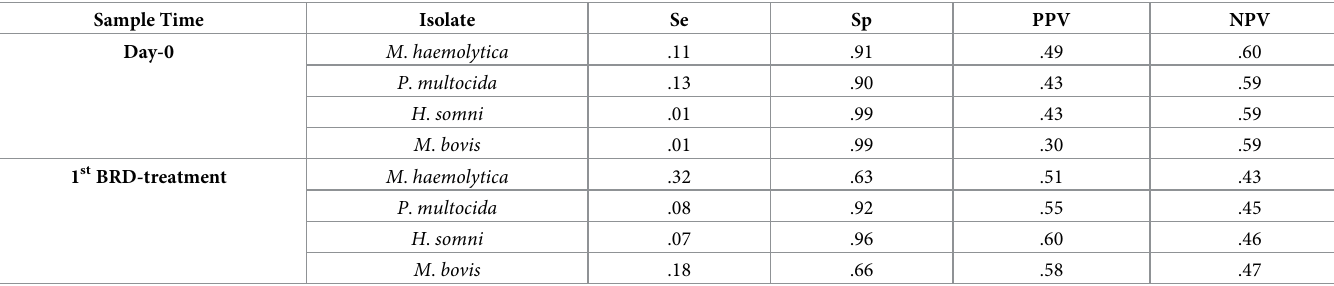
treatment is summarized in Table 6. Prevalence of positive PCR results for these four common respiratory viruses was over 50% for BRSV, over one third for bPIV-3, and one fourth for BVDV in this study population of high-risk feeder cattle. Table 7 shows that high-risk feeder heifers with positive viral PCR results from nasal swabs collected at 1 st BRD-treatment, had a higher percentage of treatment failure (ranging from 61% to 77%) compared to cattle that were negative to viral PCR at 1 st BRD-treatment (45 to 51%). Data in Table 8 suggests acceptable to moderate PPV (proportion of test positive animals with treatment failure) for BHV-l (.77), BVDV (68), bPIV-3 (.62), and BRSV (.61) and satisfac- tory specificity (ability of test to correctly identify animals with treatment success) for BHV-1 (.99), BVDV (.78), and bPIV-3 (.71) although sensitivities (ability of test to correctly identify animals with treatment failure) for all viral pathogens were low. However, NPV for all BRD viral pathogens measured, were � 51% which indicates poor validity of a negative viral PCR result to predict BRD treatment success. Data in Table 9 indicates, as the number of pathogens isolated per heifer increased, the pro- portion of cattle with treatment failure also increased. Greater frequency of one to three patho- gens per animal was measured in this population with a median of two pathogens. Two thirds of the cattle showing signs of BRD at 1 st BRD-treatment, had > 1 BRD pathogen isolated, illus- trating prevalent polymicrobial involvement of BRD in these heifers. Table 10 summarizes the relative risk of treatment failure (RRTF) at 95% confidence inter- vals associated with a positive result for each of the diagnostic procedures analyzed in this study. A value < 1.0 indicates less relative risk for treatment failure (greater probability of treat- ment success) and a value > 1.0 indicates greater relative risk for treatment failure. 95% confi- dence intervals with lower and upper limits traversing 1.0 indicate uncertainty that the relative risk is increased or decreased. 95% confidence intervals mean that if the study is conducted Table 4. Se, Sp, PPV and NPV of M . haemolytica , H . somni , M . bovis and P . multocida isolates at day-0 and 1 st BRD-treatment. Sample